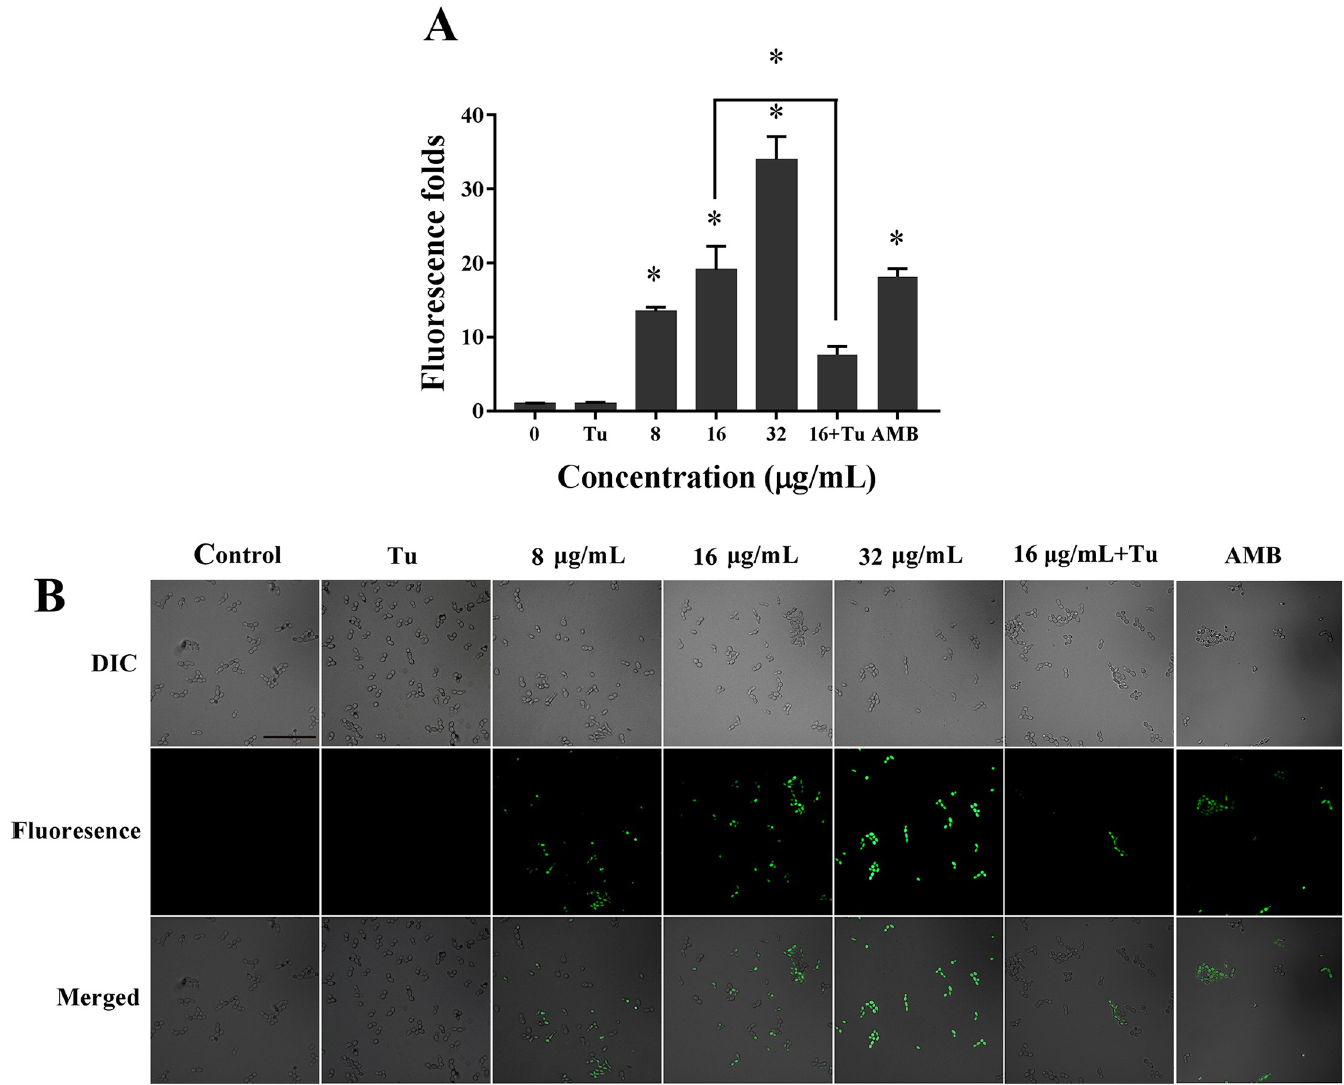
Fig 3. Effect of KPA on intracellular ROS accumulation. (A) The relative fluorescence intensity of treated cells stained by DCFH-DA was measured by a BioTek Synergy2 spectrofluorophotometer. Data represent mean values and error bars show standard deviations. � means statistically significant difference ( P < 0.05). (B) The fluorescence microscopic observation of C . albicans SC5314 with different treatments stained with DCFH-DA. Bar, 50 μ m.